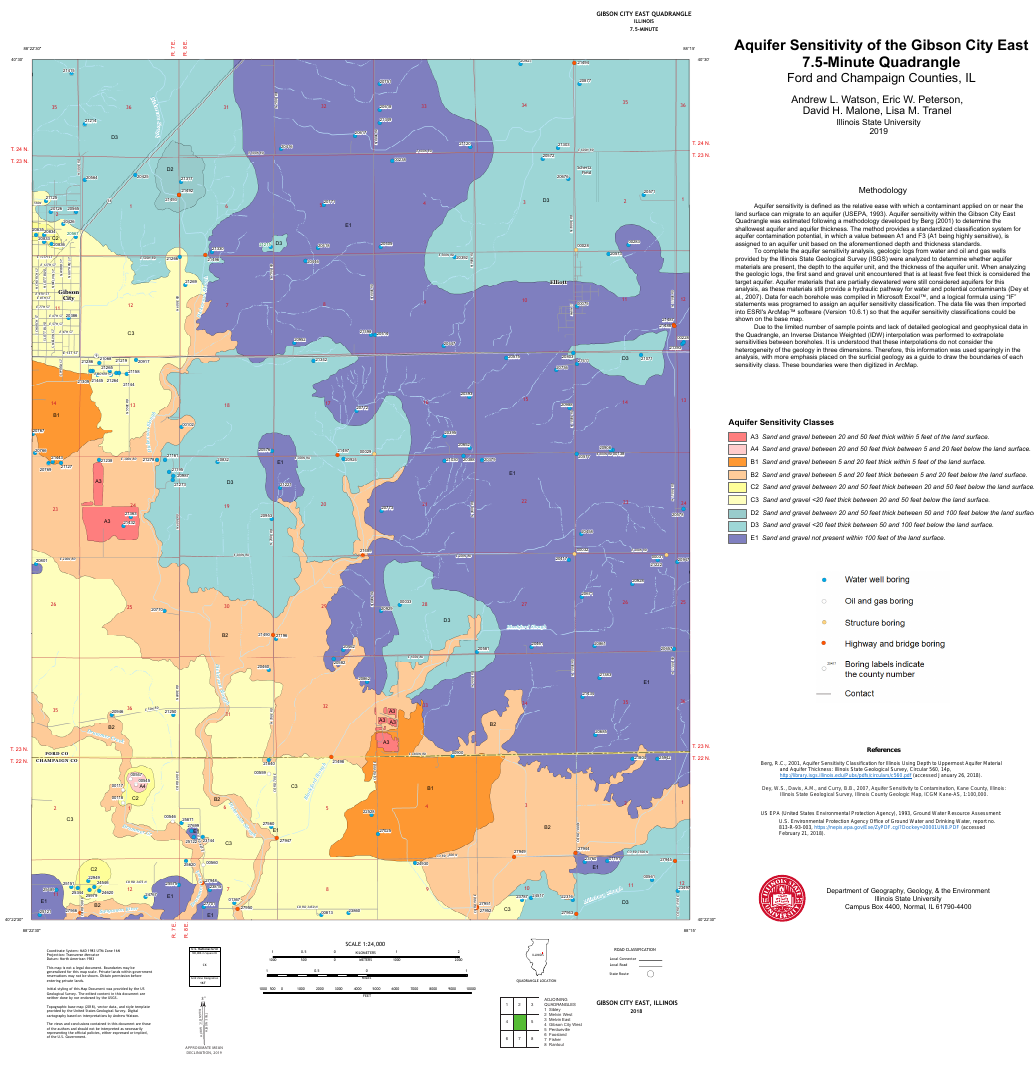
Figure 6. Aquifer sensitivity map of the Gibson City East Quadrangle. A higher resolution pdf has been provided as a supplementary